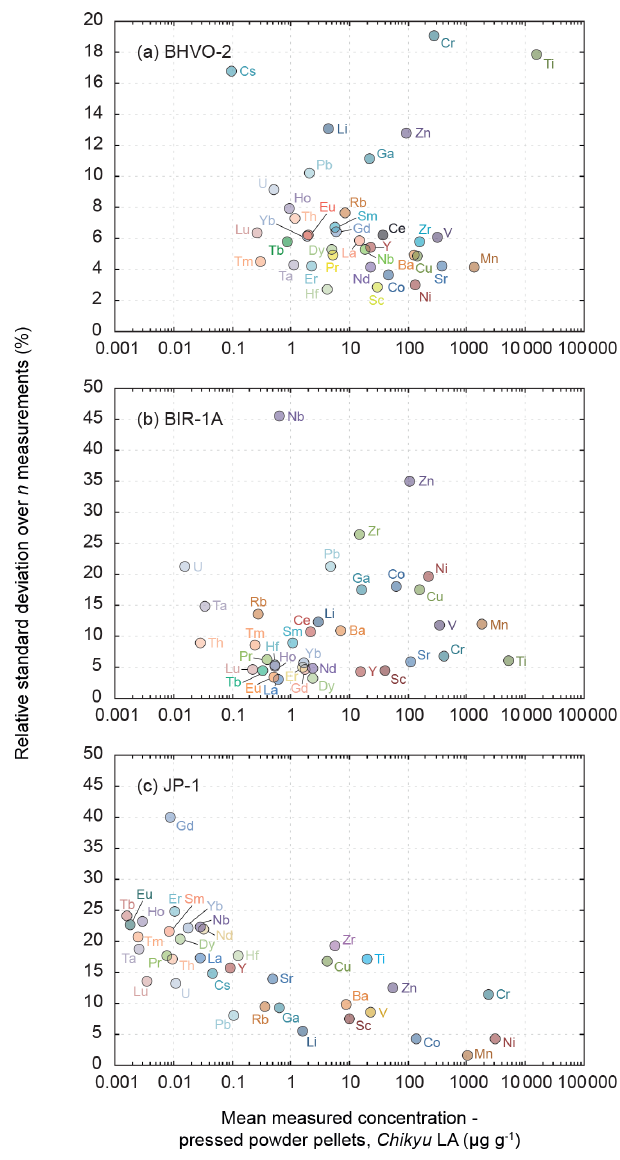
Figure 5. Evolution of the relative standard deviation (RSD, in %) relative to the measured element concentrations in the refer- ence materials (a) BHVO-2 ( n = 7), (b) BIR-1a ( n = 5) and (c) JP- 1 ( n = 10). The RSD represents the intermediate precision (or re- peatability) of the averaged composition of the multiple n measure- ments. Note the change in the scale of the y axis from BHVO-2 to BIR-1a and